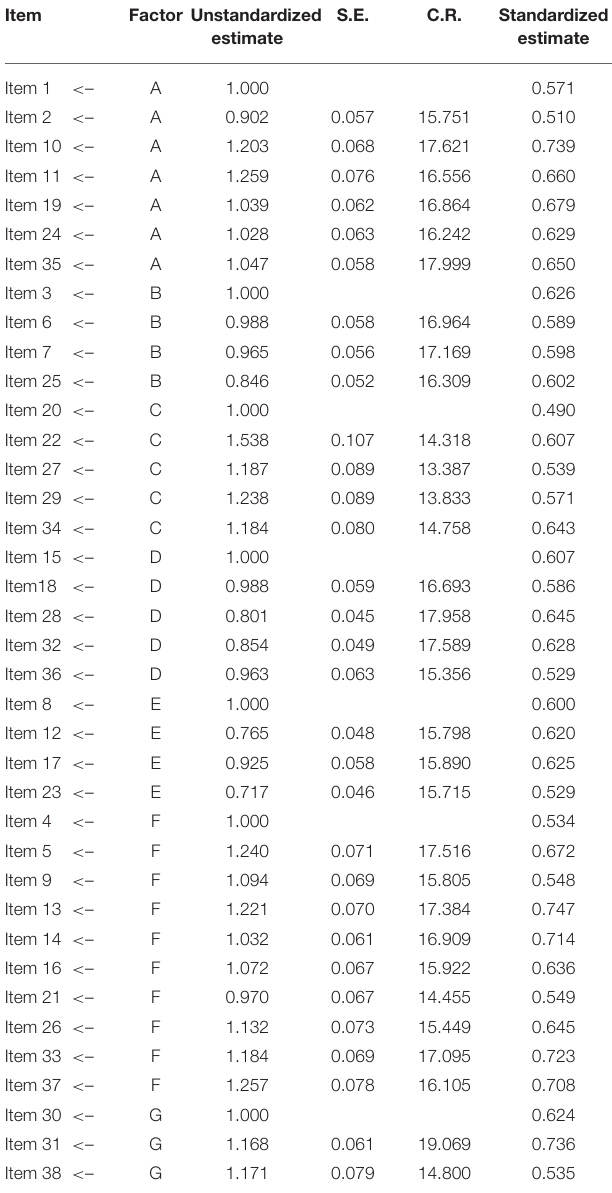
TABLE 5 | Standardized regression coefficients of the preschool learning skills scale ( n = 1,137).